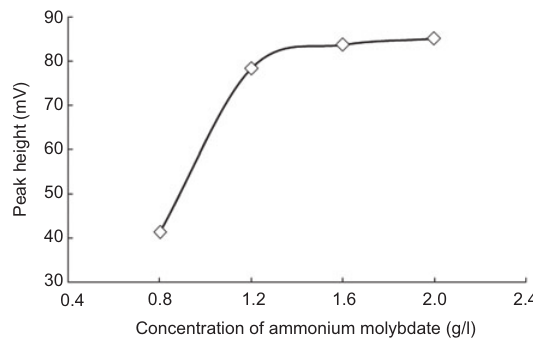
Figure 7 Effect of the ammonium molybdate concentration.